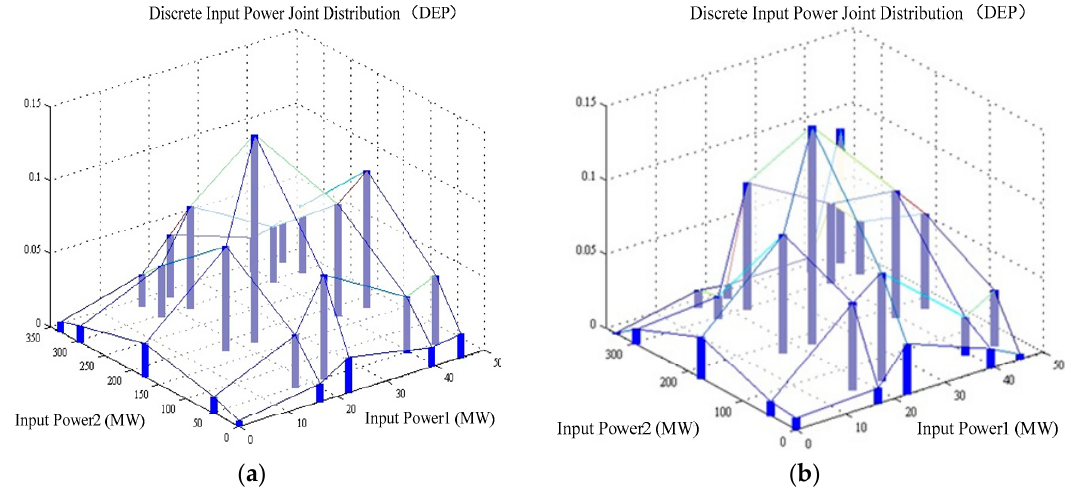
Figure 2. The probability comparison between independent and dependent wind distributions. ( a ) Independent probability; and ( b ) dependent probability.